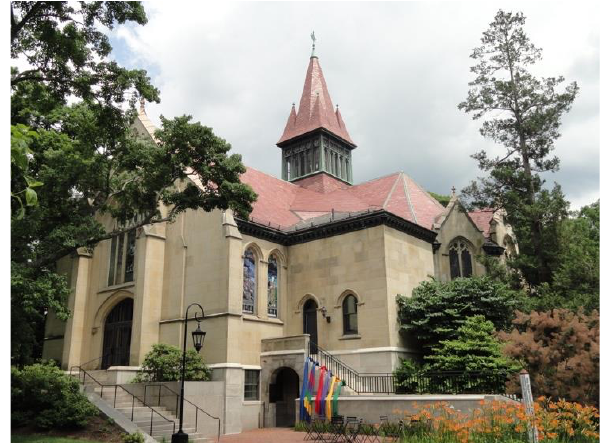
Figure 8. Houghton Memorial Chapel and Multifaith Center, Wellesley College.